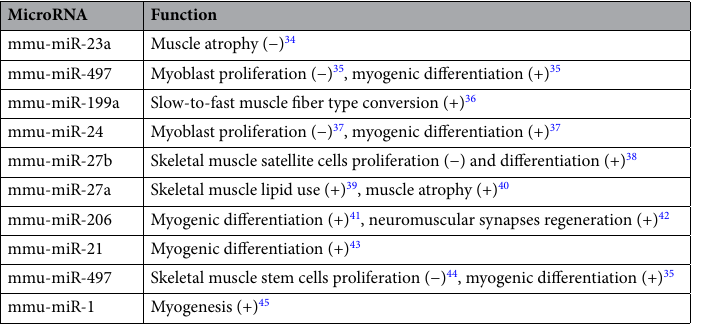
Table 7. The function of key microRNAs in skeletal muscle. + positive regulation, − negative regulation.